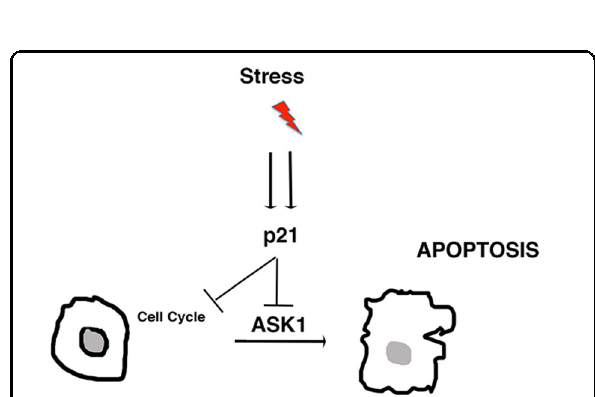
Fig. 5 Model. When exposed to environmental stress or aging cultured primary mouse keratinocytes undergo a growth arrest triggered by p21. However, under stress conditions p21 counteracts ASK1-dependent apoptosis. In contrast to wild-type keratinocytes, when exposed to stress p21-de fi ciency impedes the block of DNA synthesis. Thus, the most severely affected p21-de fi cient cells are eliminated in the course of stress by ASK1-activation. We propose that ASK1 and p21 function as a checkpoint-tumor surveillance mechanism in which ASK1 represents a mechanism for compensating loss of p21 activity. Thus, loss of the p21/ASK1 axis impairs tumor surveillance with increasing the risk of